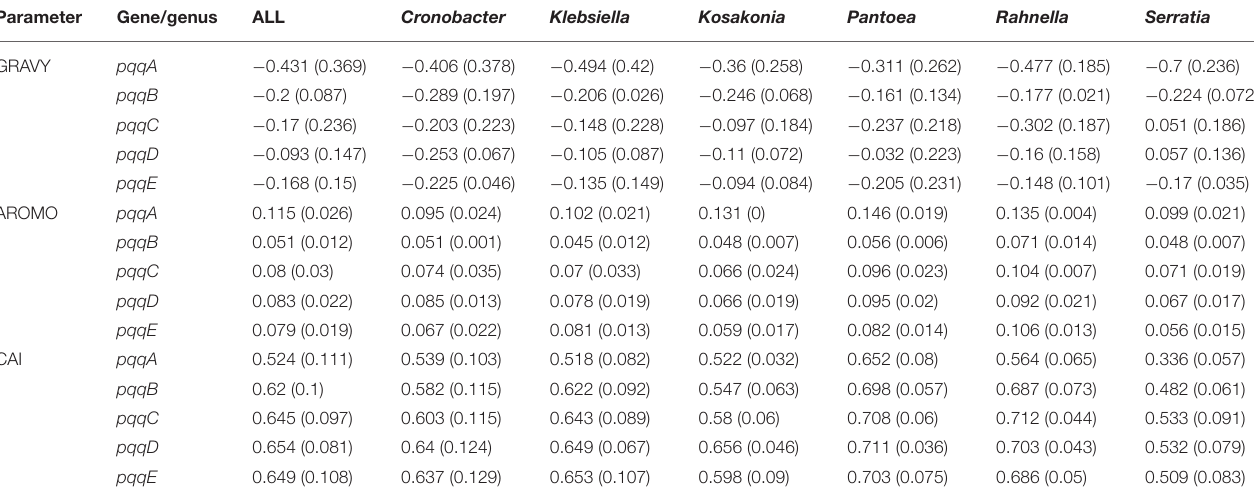
TABLE 6 | Average and standard deviation of GRAVY, AROMO, and CAI of the pqq A, pqqB , pqqC , pqqD , and pqqE genes from Cronobacter , Klebsiella , Kosakonia , Pantoea , Rahnella , and Serratia .